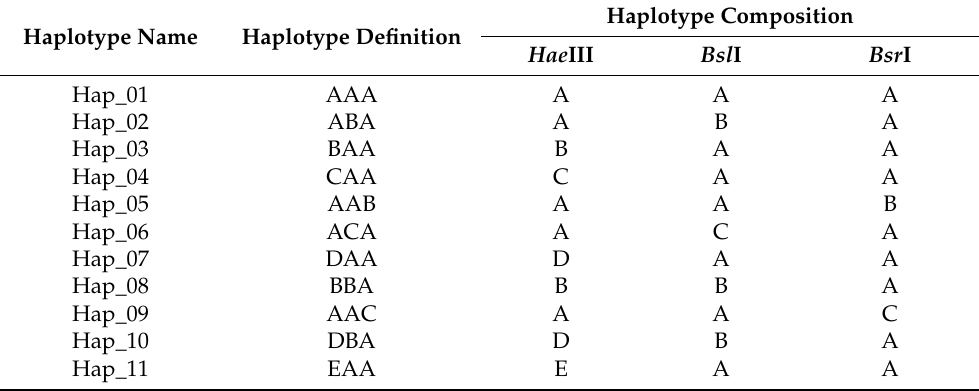
Figure 2. Restriction sites distribution of each individual enzyme haplotype. Table 2. The composite haplotypes definition and composition: 11 composite haplotypes were observed out of 45